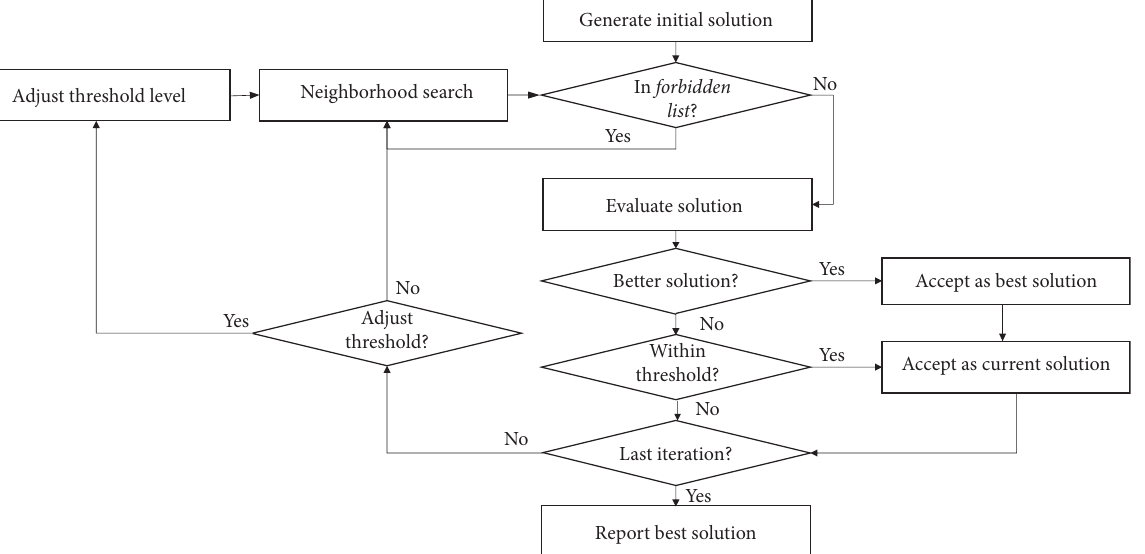
Figure 3: A TA-NS algorithm diagram.